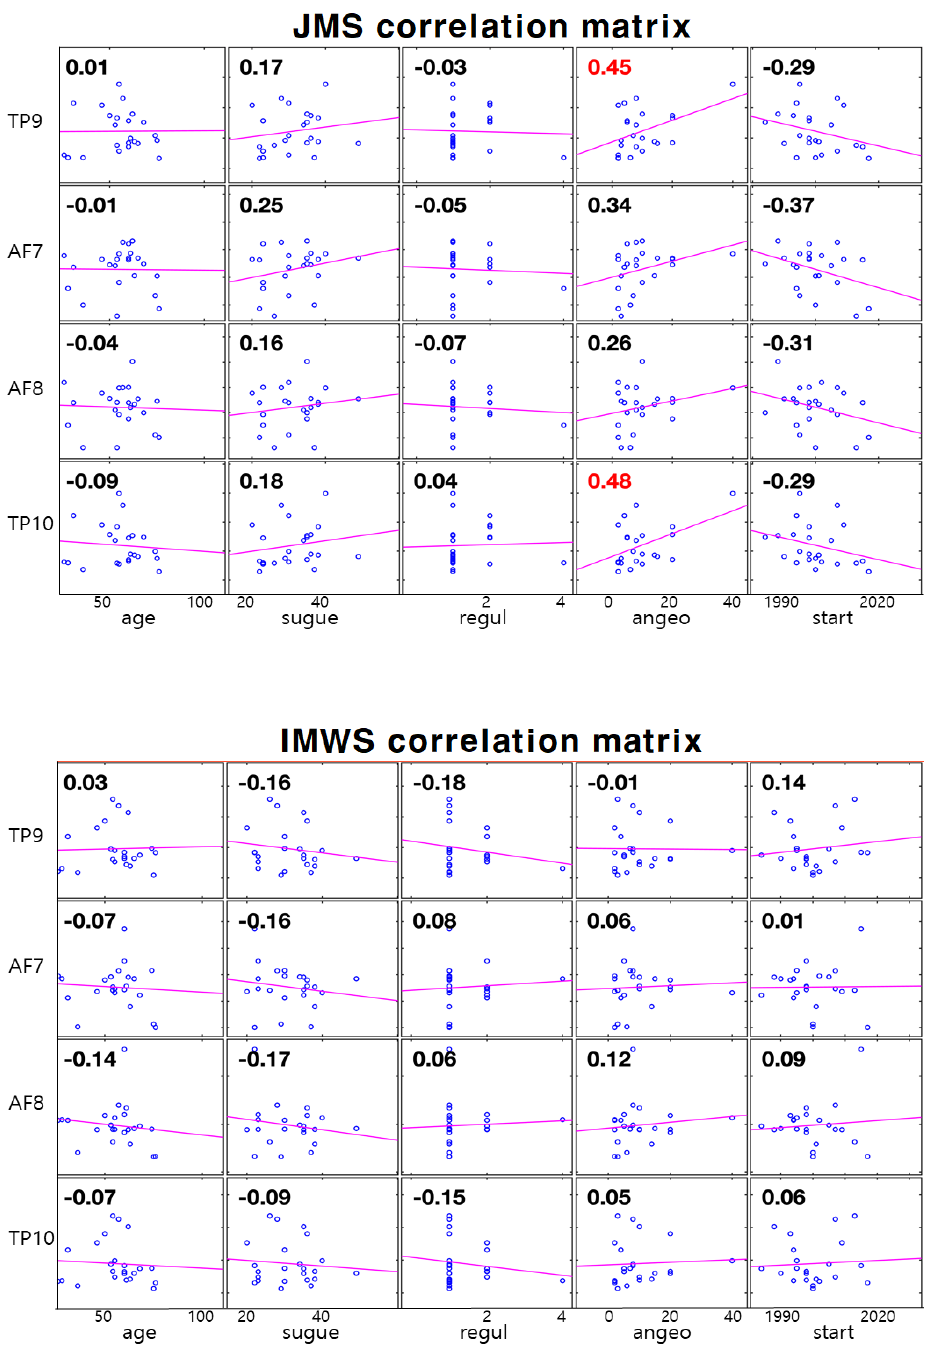
Figure 6. Correlation matrix between EEG channels (theta/alpha ratio of TP9, AF7, AF8, TP10) and questionnaire items. The top is JMS (Juingong meditation state), the bottom is IMW state correlation matrix. Sugye: frequency of attending ‘sugye’ events; regul: frequency of attending regular worship; angeo: frequency of participation of intensive training sessions; start: the date practitioners first came to the Hanmaum Seon Center. The purple line represents the trend line. The small blue circle in the box represents one practitioner. The number in each box represents the Pearson-r value.